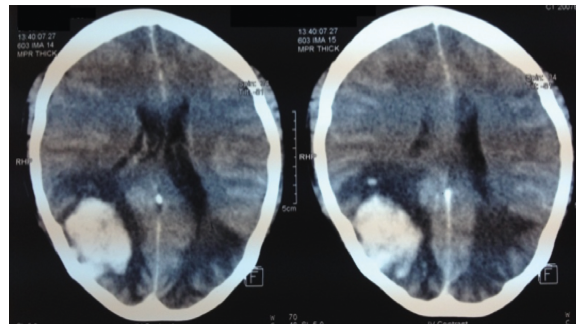
Figure 1: Contrast-enhanced cranial CT demonstrating a hem- orrhagic focus in the right parietal and occipital lobes with possible secondary bilateral infarction due to compression of posterior circulation vessels, subfalcine herniation, beginning uncal herni- ation, and cerebral edema.